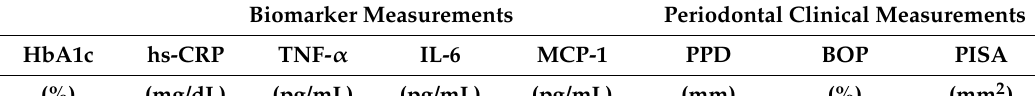
Table 5. Correlations between changes in HbA1c, inflammatory markers, and clinical parameters between the FM-SRP group and the control group combined over nine months. Biomarker Measurements Periodontal Clinical Measurements HbA1c TNF- α IL-6 MCP-1 PPD BOP